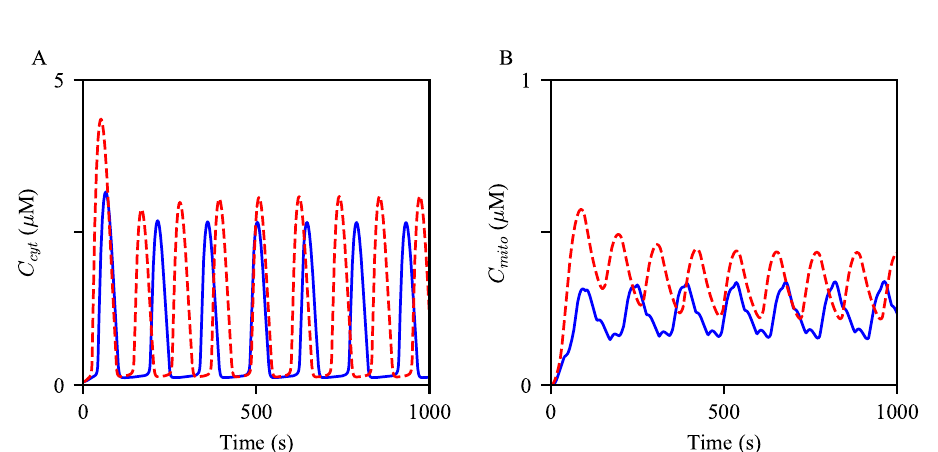
Fig 10. Effects of increased IPR activity on Ca 2+ oscillations. Oscillations of (A) cytosolic and (B) mitochondrial Ca 2 + concentrations generated from the control model, in blue, and the model with the increased k dashed. The model was given continuous stimulation of IP 3 with P s = 0.3 μ